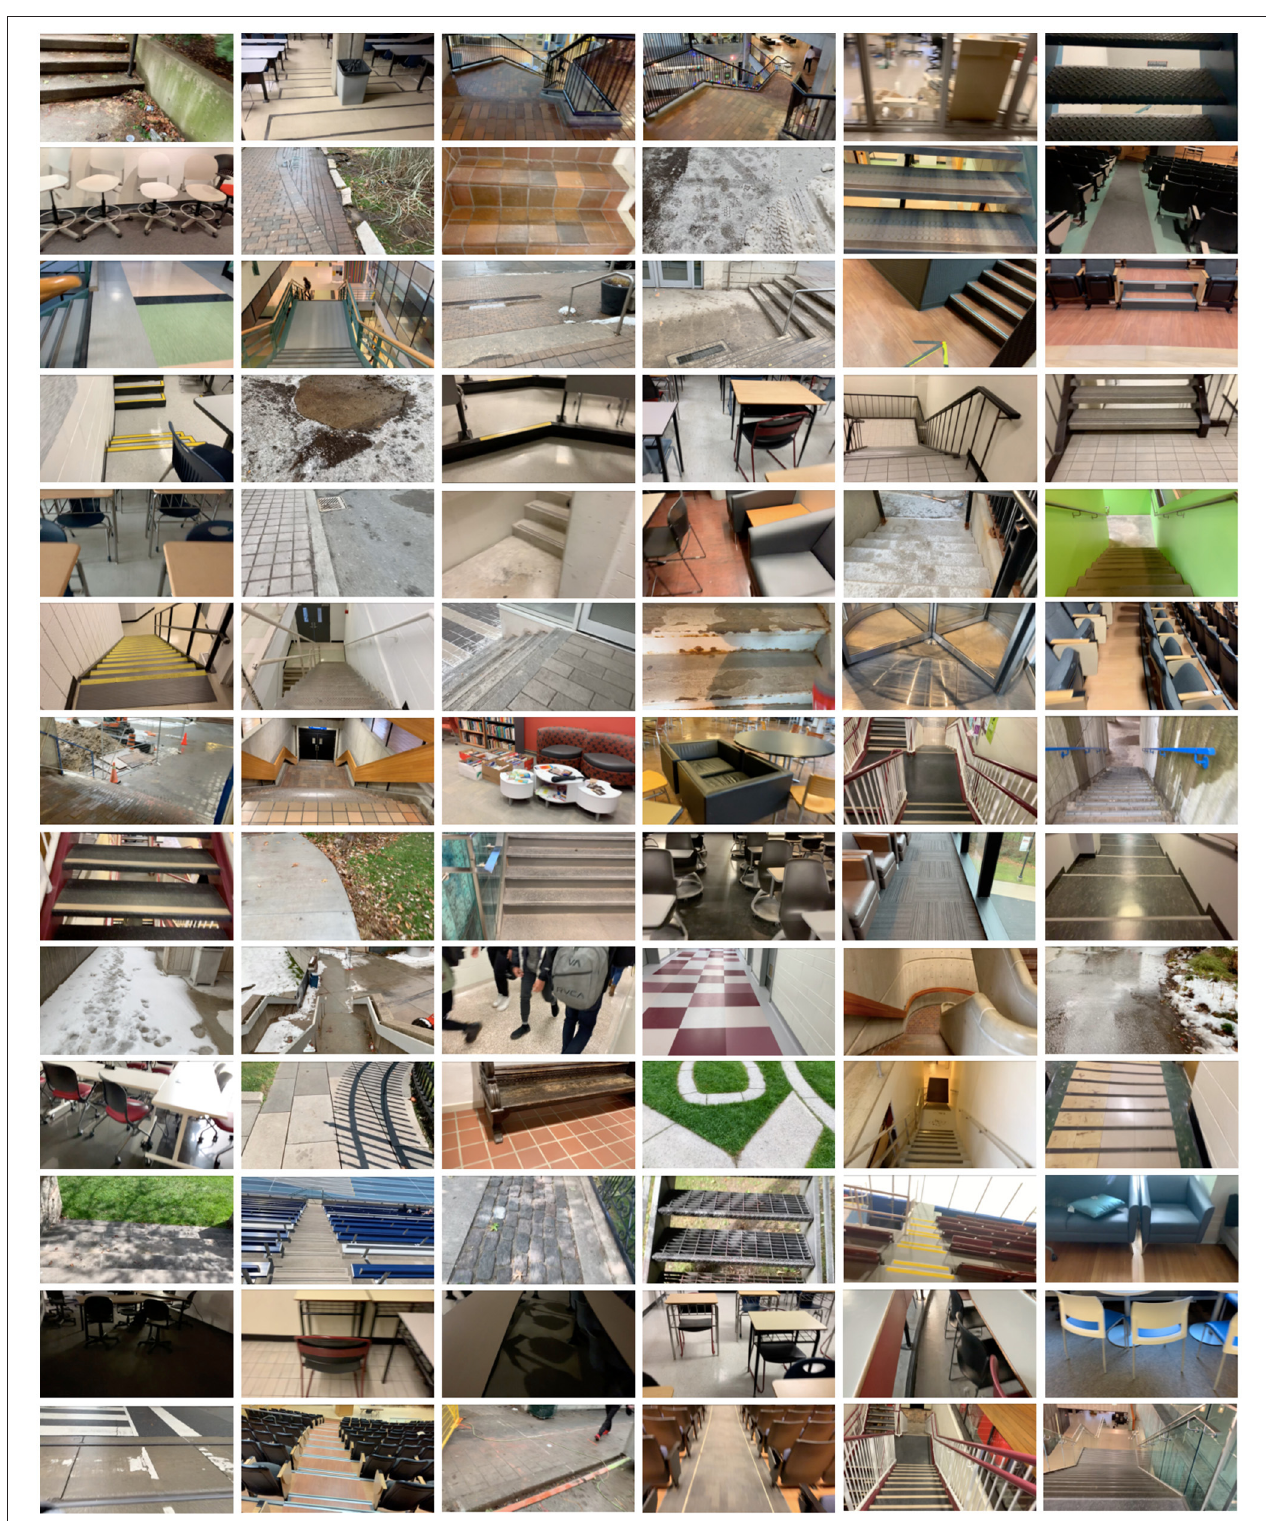
FIGURE 5 | Examples of the wearable camera images of indoor and outdoor real-world walking environments in the ExoNet database. Images were collected at various times throughout the day and across different seasons (i.e., summer, fall, and winter).